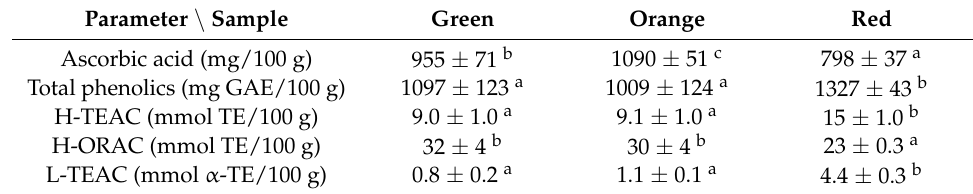
Table 3. Antioxidant capacity, total phenolic contents and ascorbic acid contents in R. rugosa hips at different ripening degrees. Parameter \ Sample Green